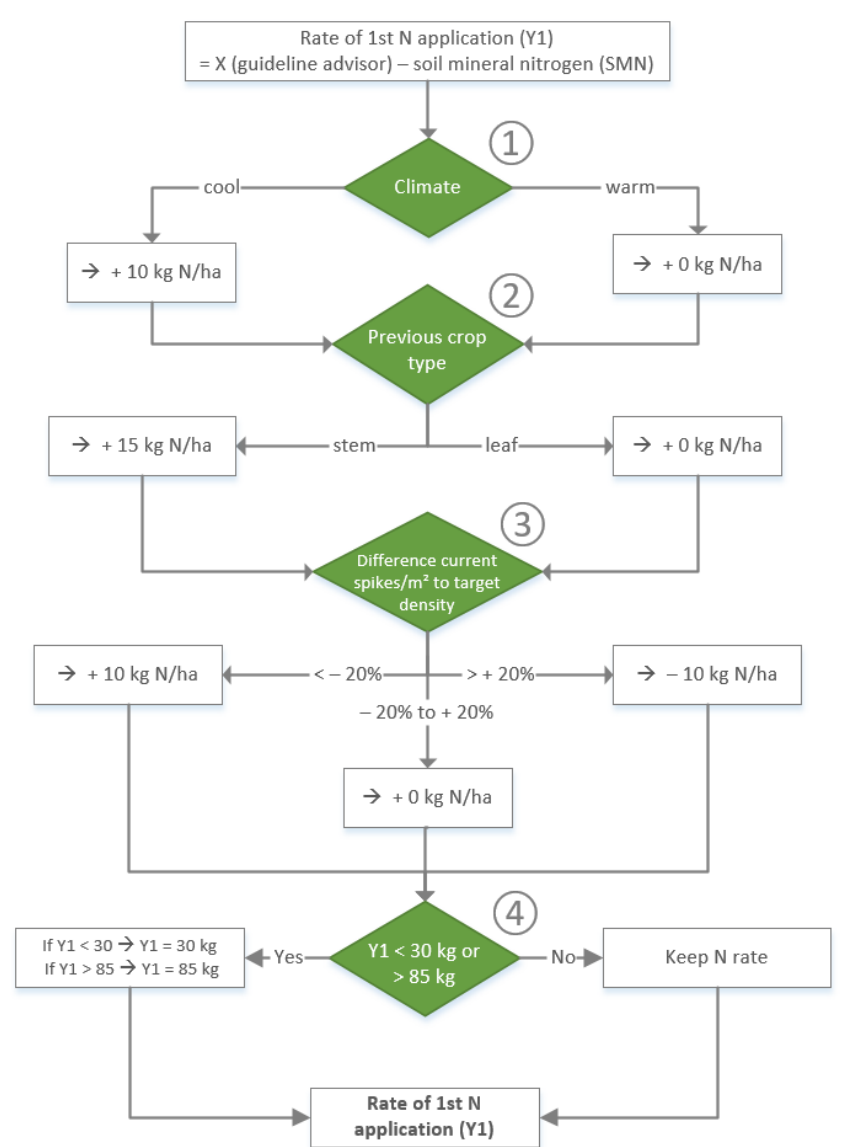
Figure 2. Decision tree for determining the amount of N for the 1st rate of application. The advisors’ rule of thumb for N requirements of the crop at the beginning of vegeta- tion was 115 kg N ha − 1 (X) for the 1st RoA. The scope of application of this rule assumes a yield potential of ≥ 80 dt ha − 1 and includes the SMN content. It also assumes an average humus-rich mineral soil, with 1–2% humus. The parameters marked 1 (cid:13) to 4 (cid:13) , with the respective surcharge and discharge rates, are composed in Table 2. For more details on the explanation of the parameters, see Appendix